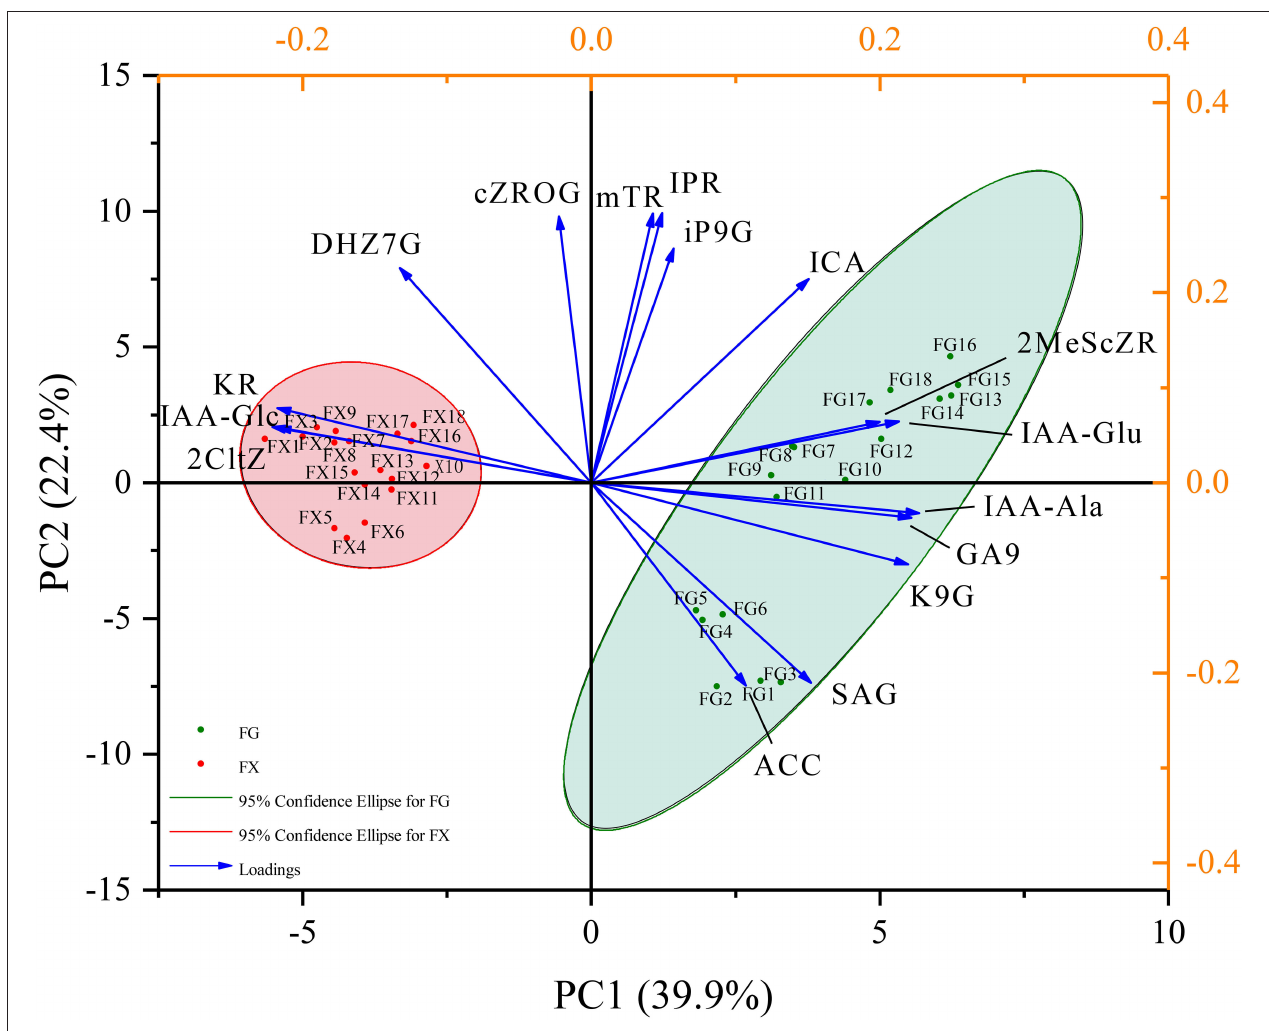
FIGURE 3 | The principal component analysis (PCA) of the plant hormone components for Z. bungeanum varieties FG and